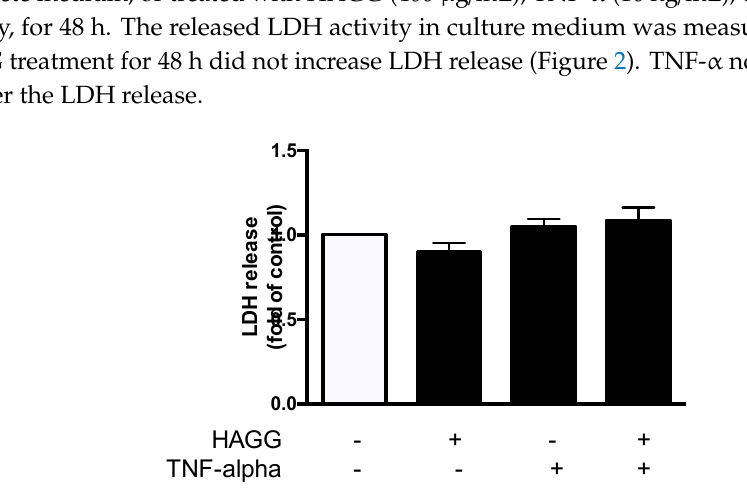
Figure 2. E ff ects of HAGG on GEC necrosis. GECs were treated with complete medium (control), HAGG (400 µ g / mL), TNF- α (10 ng / mL), or TNF- α plus HAGG, for 48 h. Necrosis was measured using LDH release assay. Data was presented as mean ± SEM ( n = 8) and analyzed by one-way ANOVA.